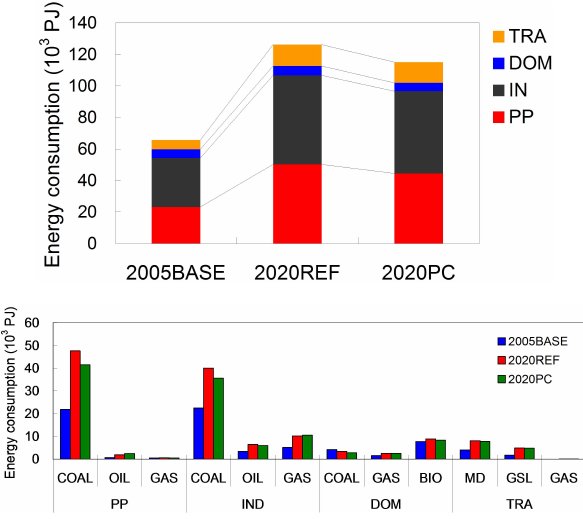
Fig. 1. Energy consumption in 2005 and 2020 (Sector: PP – Power plants; IND – Industry; DOM – Domestic; TRA – Transport; Fuel: COAL – raw coal, washed coal, coke, briquettes; OIL – fuel oil, diesel, kerosene, raw oil, gasoline, liquefied petroleum gas (LPG); GAS – nature gas, coal gas, other gas; BIO – straw, brushwood; MD – diesel, kerosene, raw oil; GSL – gasoline). (a) Energy con- sumption by sectors in 2005 and 2020. (b) Energy consumption by fuel type in 2005 and